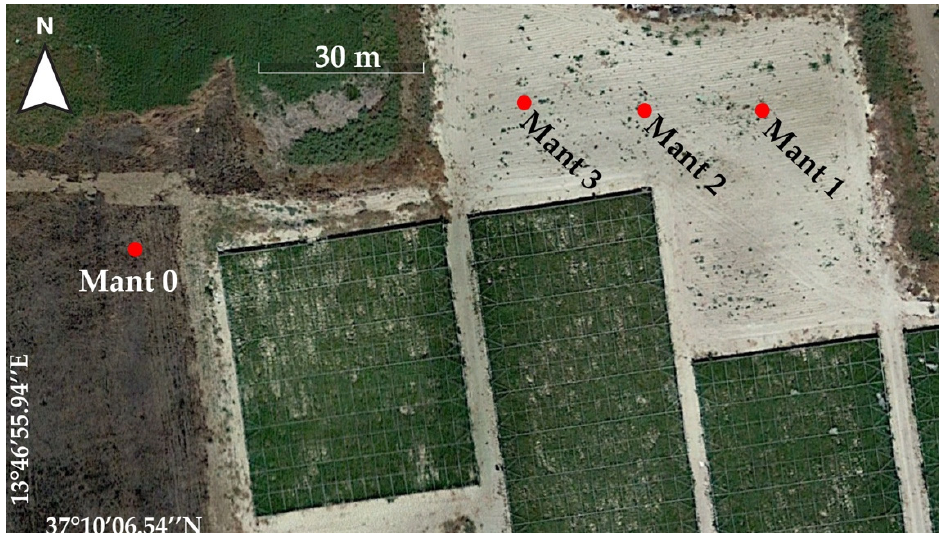
Figure 2. Sampling points. Red circles are soil profiles.